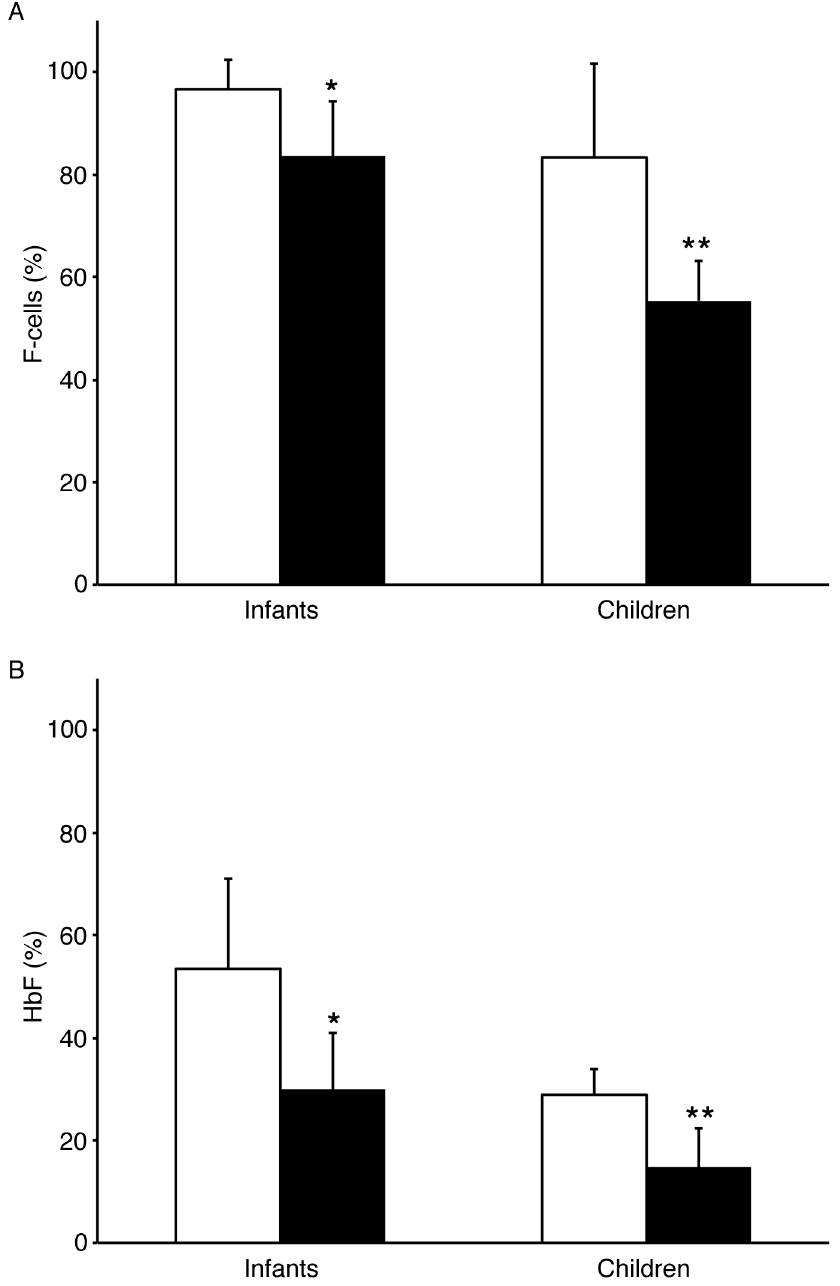
Fig 4. Comparison of F-cell and HbF levels in Infants and Children with ARC < 200 K/ μ L and ARC (cid:1) 200K/ μ L. A. F-cell level comparisons in infants less than 1 year of age and children between ages 1 – 9 years with an ARC < 200 K/ μ L (open bars) and ARC (cid:1) 200 K/ μ L (shaded bars) ( * p = 6.2 E-5, ** p = 1.7E- 6). B. Comparison of HbF levels in infants and children ages 1 – 9 years and ARC < 200 K/ μ L (open bars) and ARC (cid:1) 200 K/ μ L (shaded bars) ( * p = 2.2E-5, ** p = 7.4E-7). Standard deviation bars are included.